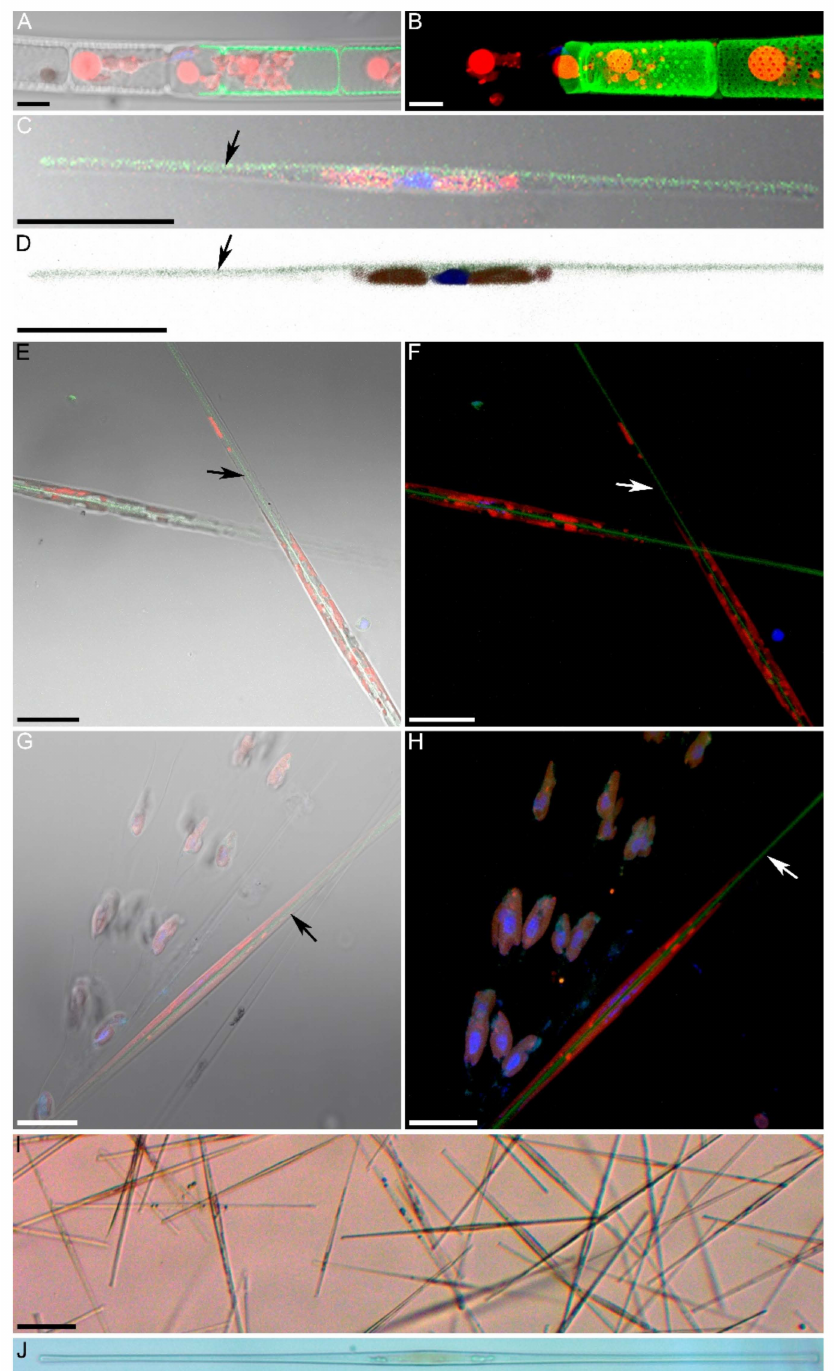
Figure 3. Visualisation of silica deposition in diatom cells by Lysotracker Yellow HCK-123 staining. ( A , B ) Formation of thick valves of Aulacoseira baicalensis , spring (May) 2018, Station 5; ( C , D ) formation of thin valves of Nitzschia graciliformis , May 2019, Station 3; ( E – I ) Fragilaria radians ; ( G , H ) left: Dinobryon cylindricum ; ( E , F ) under-ice sample from Station 10, March 2019; (G,H): May 2019, Station 5; ( I ) light microscopy; ( A – H ) laser confocal scanning microscopy, optical section, and 3D reconstruction, respectively. Green—fluorescence Lysotracker incorporated into forming valves (arrows); red— autofluorescence of chloroplasts; blue—DAPI-stained DNA. Scale bars: ( A , B , E – H , J )—20 µ m; ( C , D )— 10 µ m; ( I )—50 µ